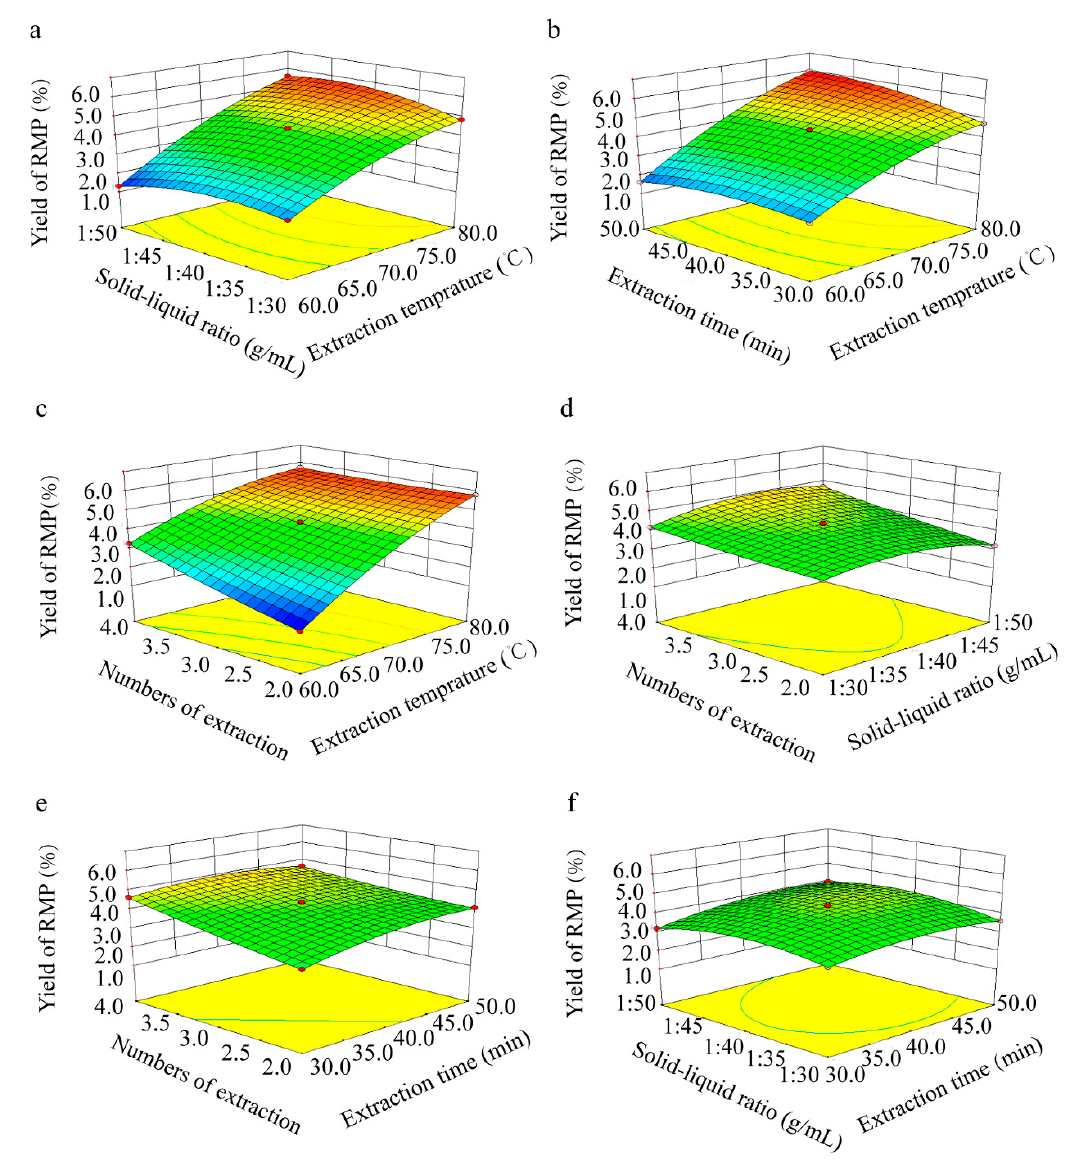
Figure 2. 3D response surface plots showing the interaction effects on the RMP extraction yield: ( a ) Solid–liquid ratio and extraction temperature; ( b ) extraction time and extraction temperature; ( c ) number of extractions and extraction temperature; ( d ) number of extractions and solid–liquid ratio; ( e ) number of extractions and extraction time; and ( f ) and solid–liquid ratio and extraction time.